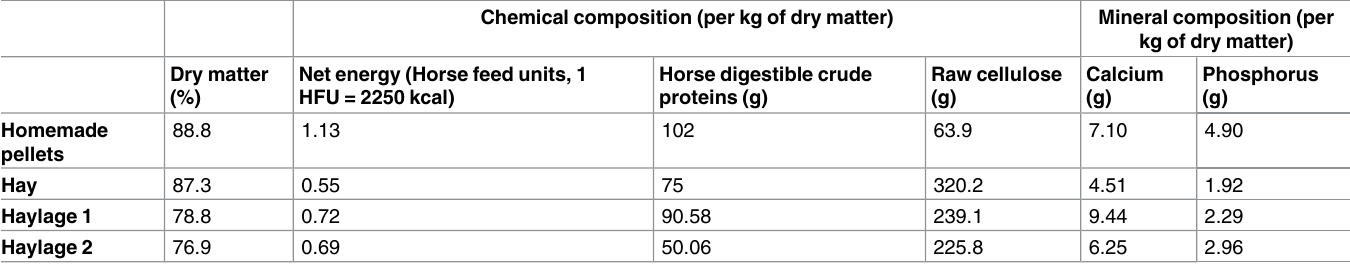
kg of dry matter)